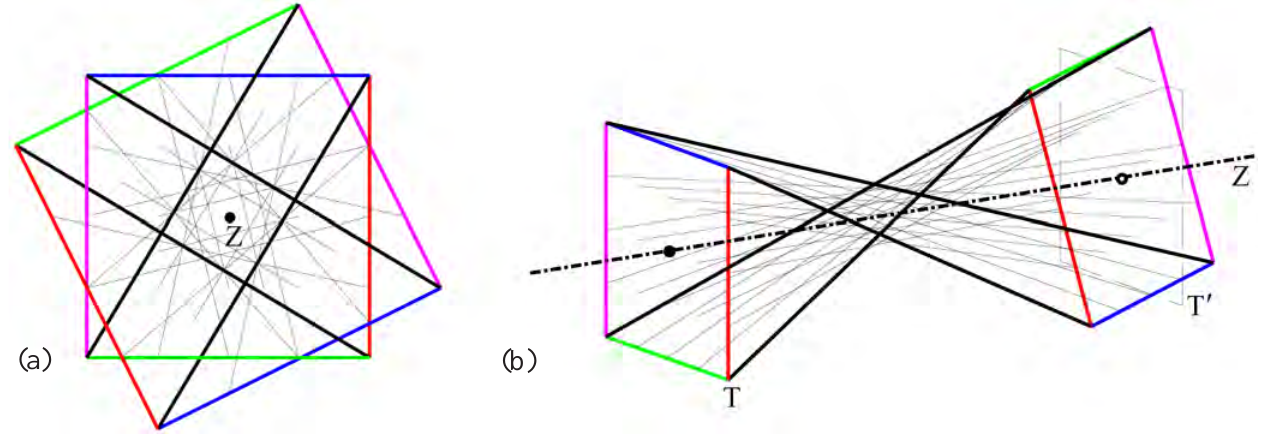
Figure 7 A pencil with divergency IM −= D at T. The pencil is conventional with focal plane and point focus. All meridional planes are principal meridional planes. (b) azimuth °− 64 34 °− 64 , elevation 14 °− 64 .